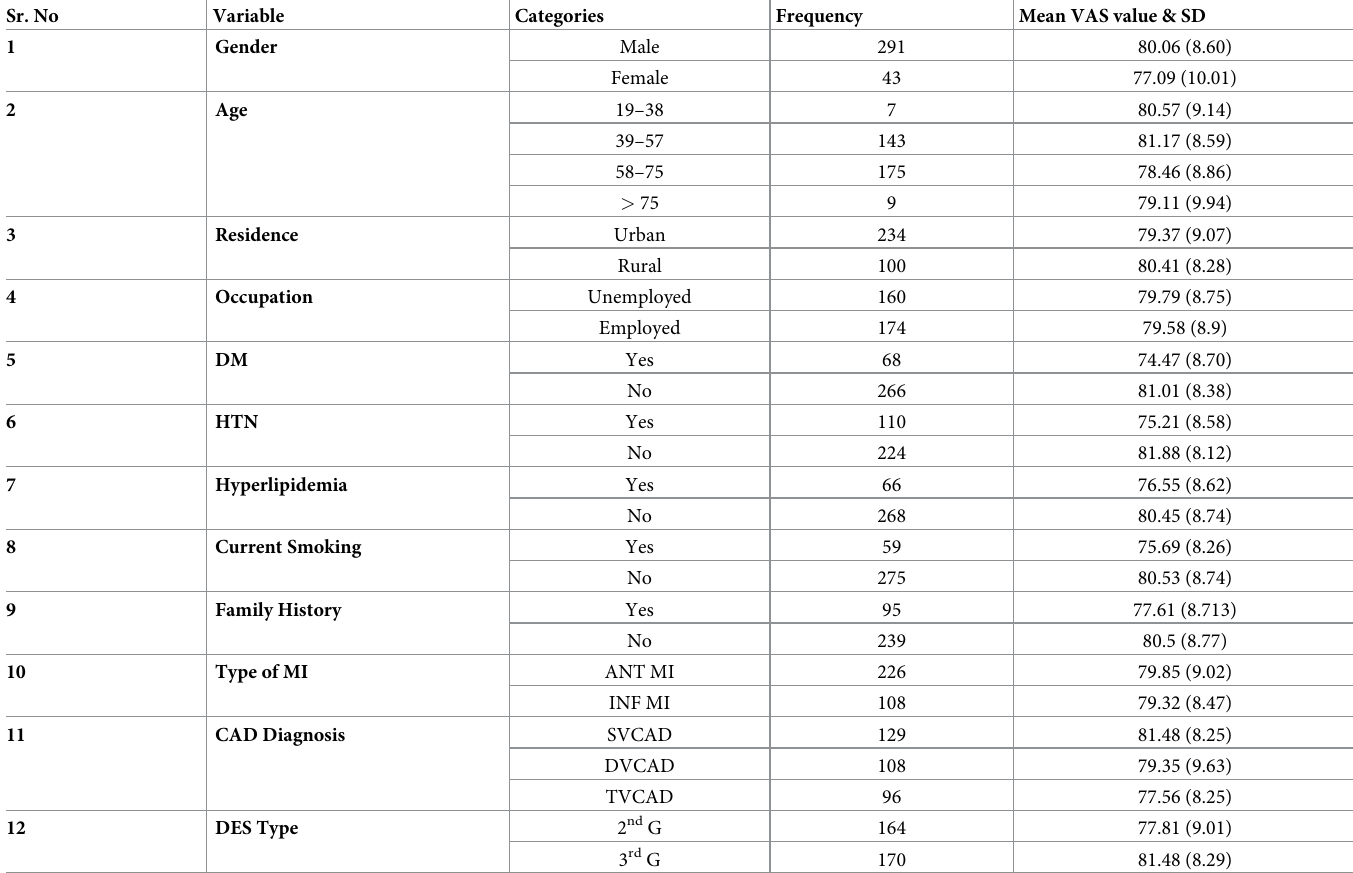
Table 4. Distribution of VAS values among independent